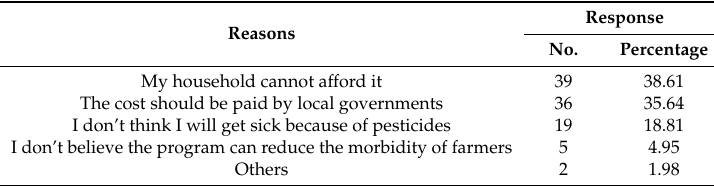
Table 3. Reasons for saying “no” to the WTP question.